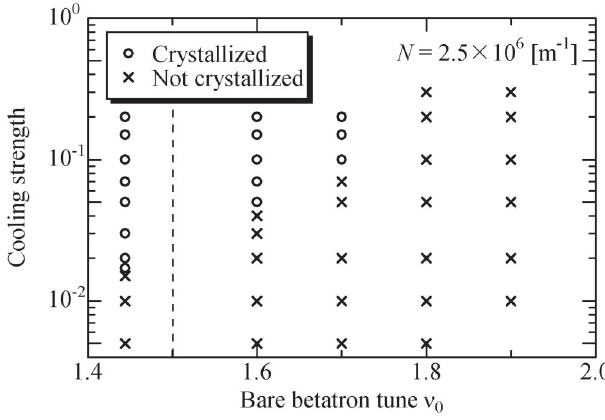
FIG. 5. Required cooling strength for beam crystallization vs transverse tune. The simulation parameters are the same as those assumed in Fig. 3 except for the betatron tunes and cooling strength. For the sake of simplicity, the horizontal and vertical tunes have been set equal in all MD simulations, i.e., (cid:4) (cid:5) . The beam is cooled with a 3D linear frictional force that has (cid:4) 0 identical cooling rates in the three directions. In the region (cid:4) 1 : 8 , a crystalline state cannot be reached at this line density even if the friction is considerably enhanced. Even when (cid:4) is difficult to achieve crystallization with a low cooling rate because of the heating from intrabeam scattering (see Fig. 3). Note that the lattice of S-LSR has sixfold symmetry ( N The vertical broken line in the picture indicates the threshold tune determined by Eq. (4).